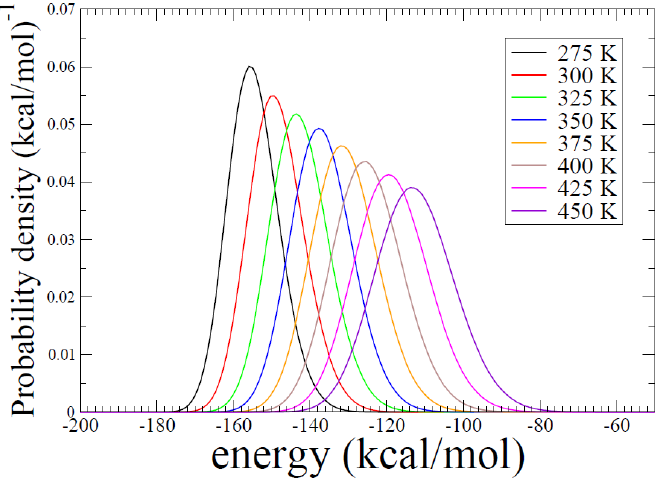
Figure 6. Probability density functions obtained from the REMD simulation are shown for eight temperatures. Significant overlaps are observed between neighboring